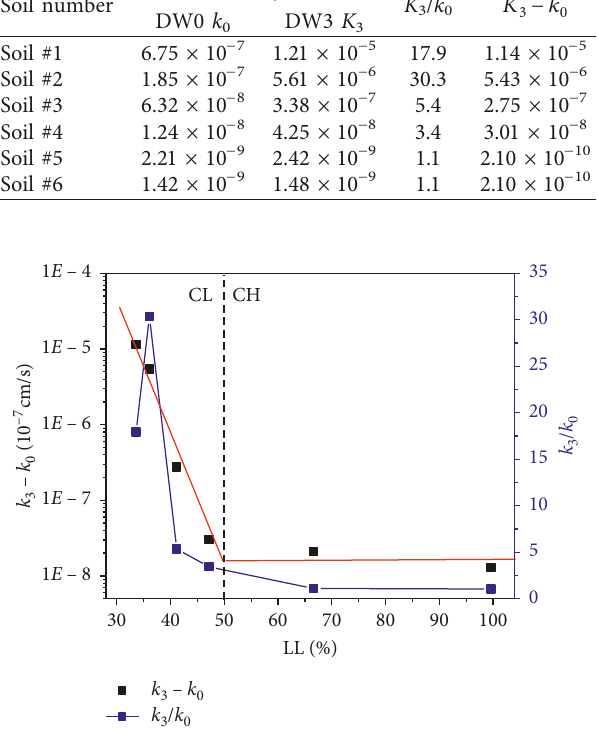
Figure 11: Change in CCL permeability as soil LL increases after dry-wet